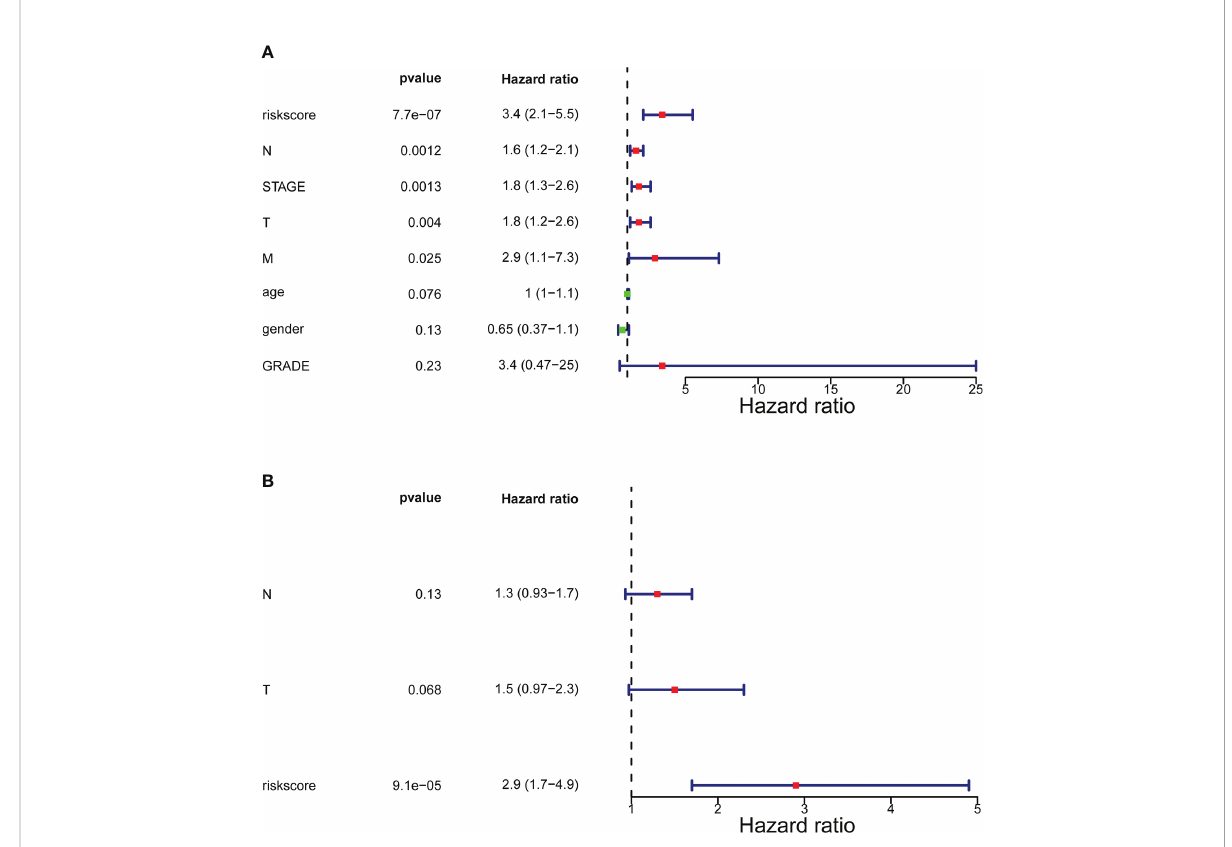
FIGURE 4 Forrest plot of the univariate and multivariate Cox regression analysis. (A) Engaged clinical characteristics into univariate Cox regressive. (B) Multivariate Cox regressive. The green square indicates that the HR value is less than 1, the red square indicates that the HR alue is larger than 1, and the line segments on both sides of the square are the 95% con fi dence interval of the HR